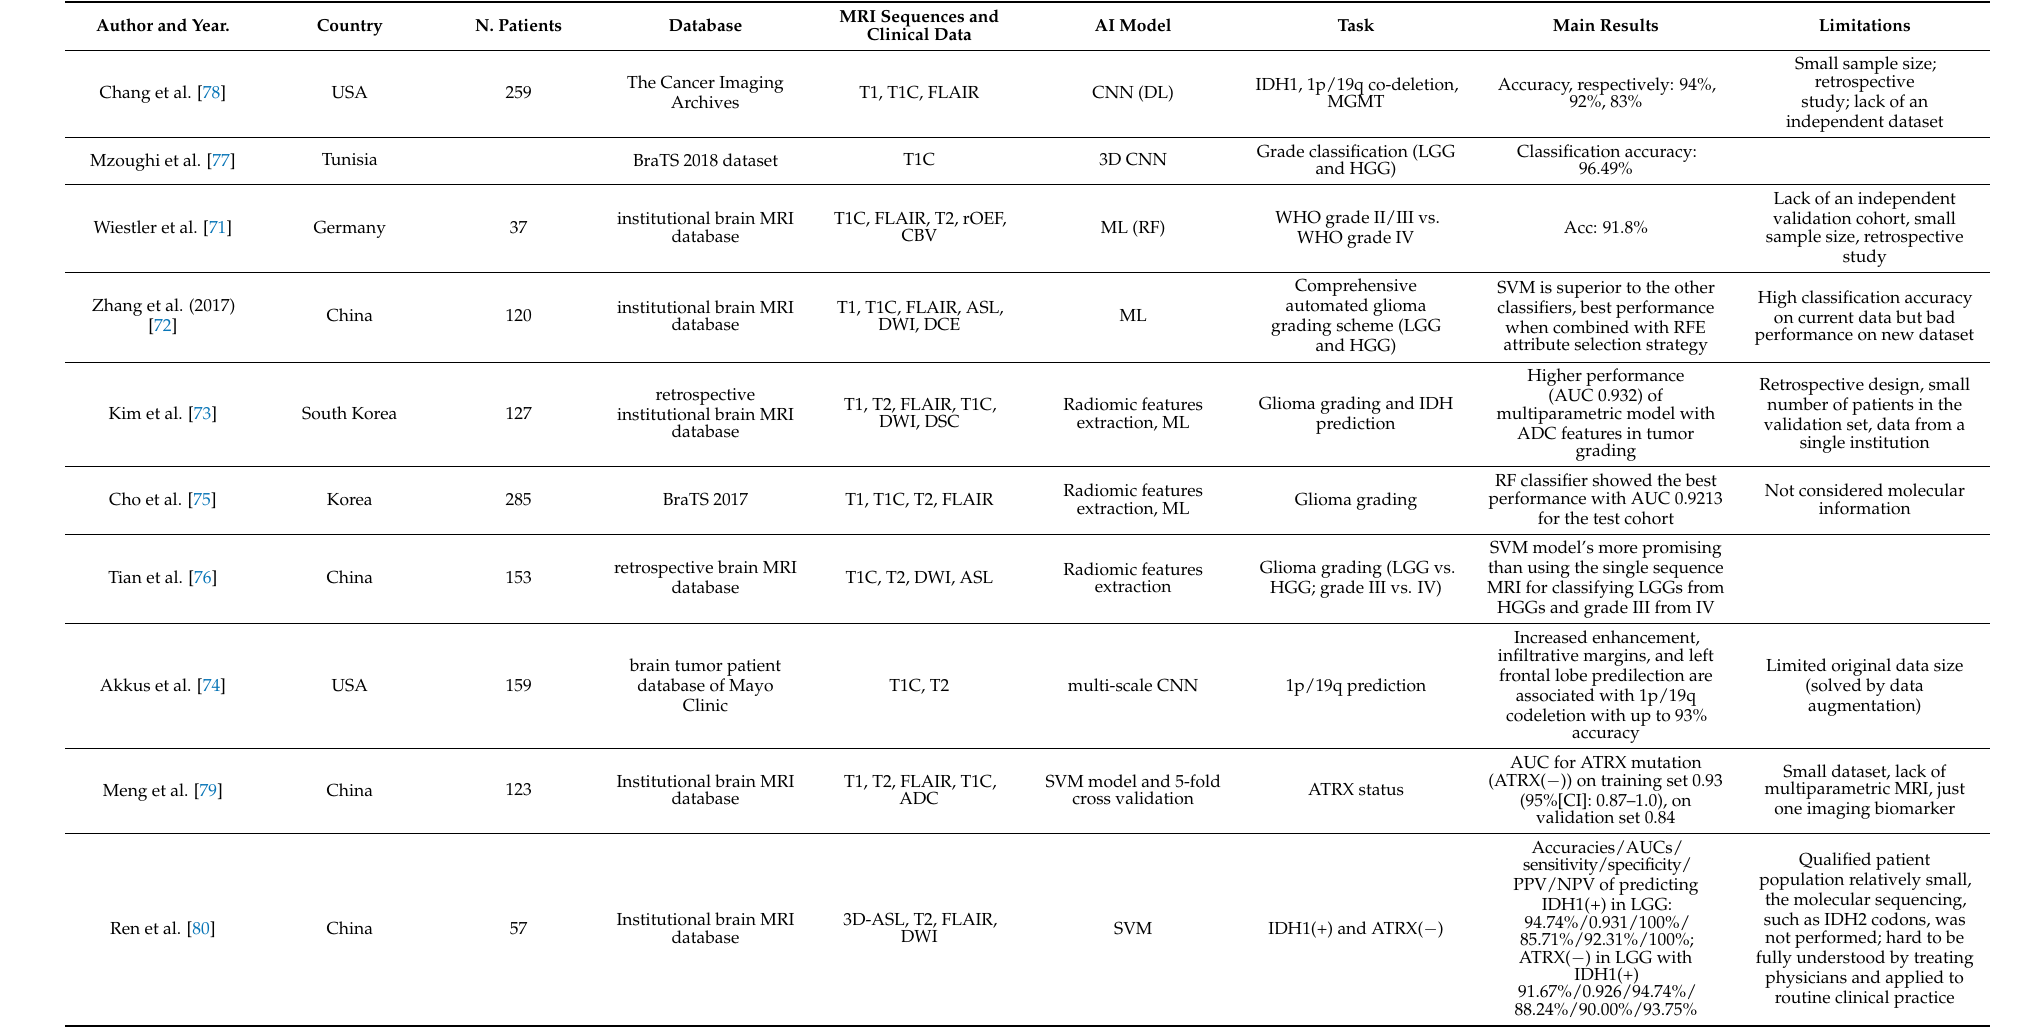
Table 2. The main characteristics and findings of the studies focused on the characterization of brain